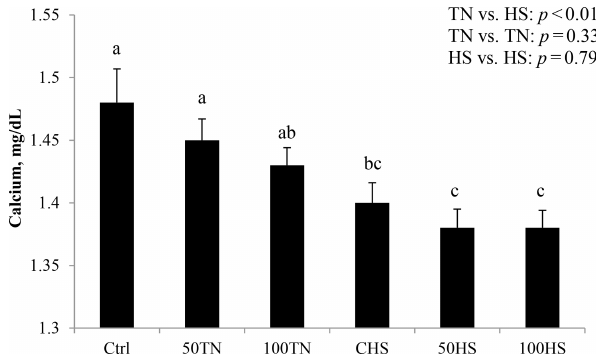
Figure 3. Effects of feeding different levels of organic zinc under TN and HS conditions on blood calcium in broiler chickens. Results are expressed as LSM ± SEM.